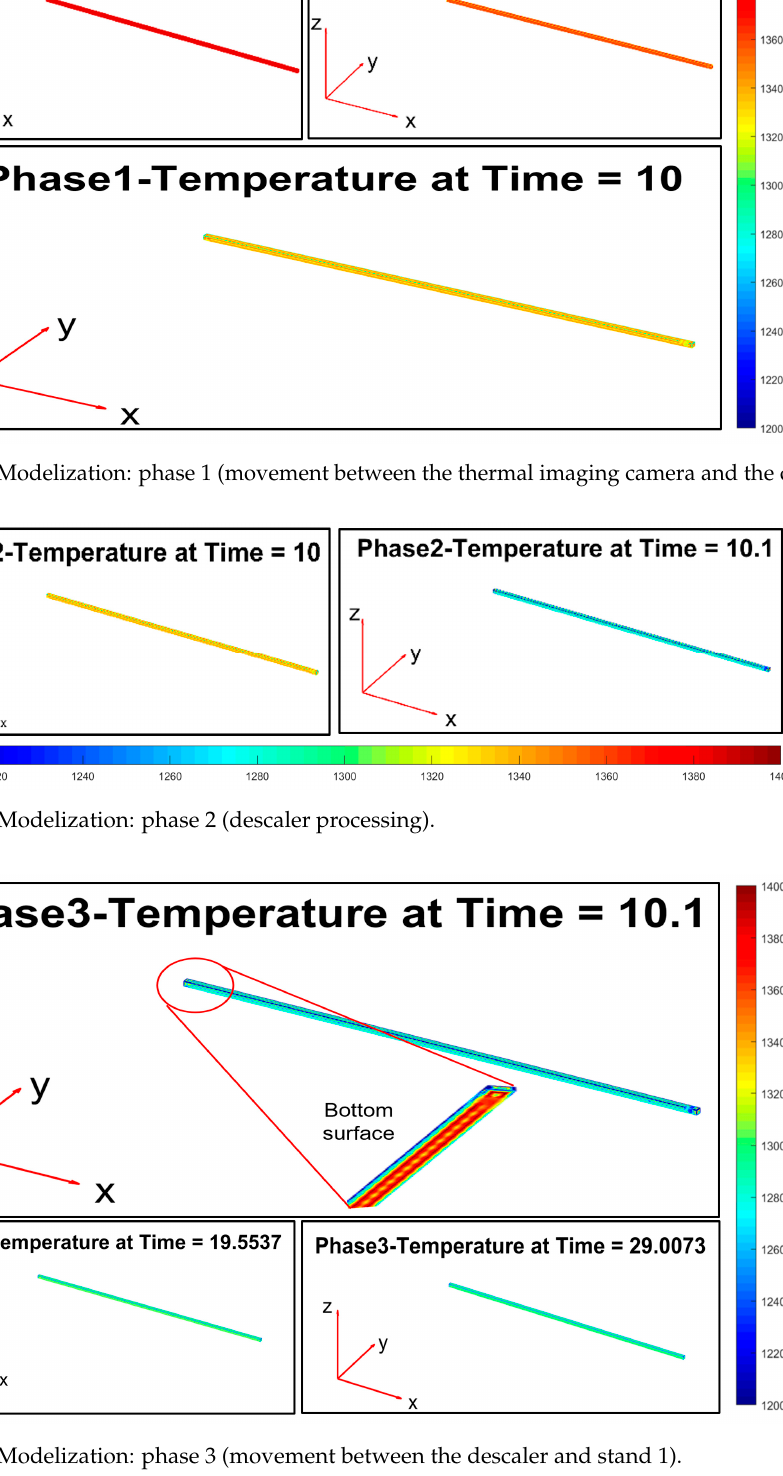
Figure 16. Modelization: phase 4 (processing between rolling mill stands 1–2). Figure 17. Modelization: phase 5 (movement between stand 2 and stand 3).